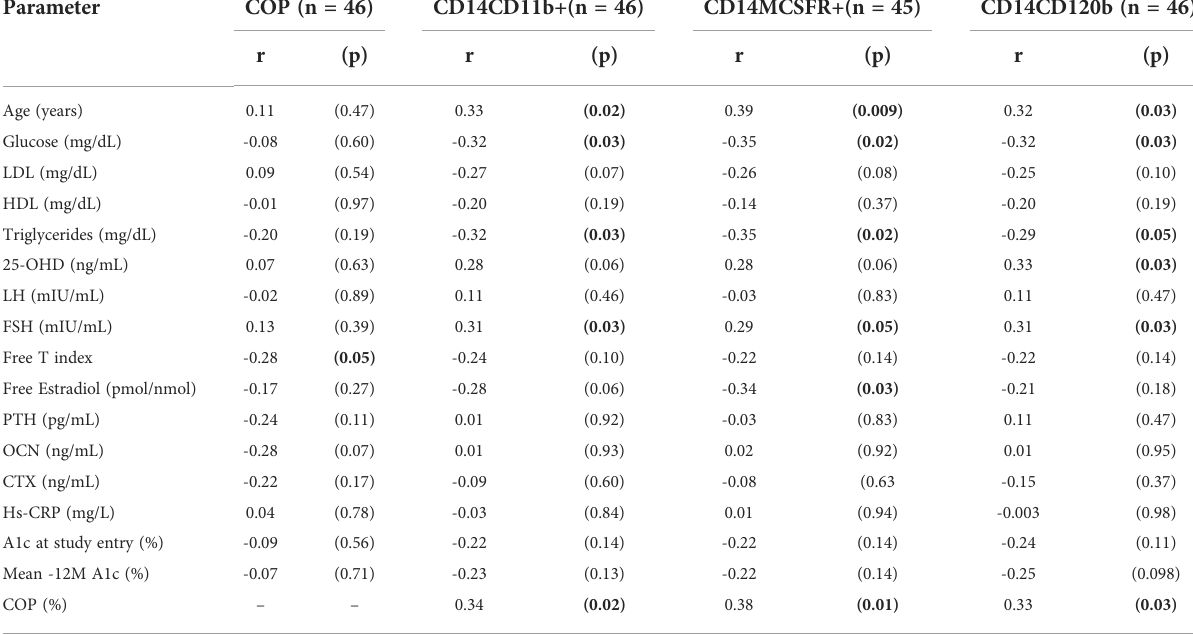
TABLE 3 Correlation analysis of circulating osteogenic progenitors and osteoclast precursors on hormonal and metabolic parameters of interest. Parameter